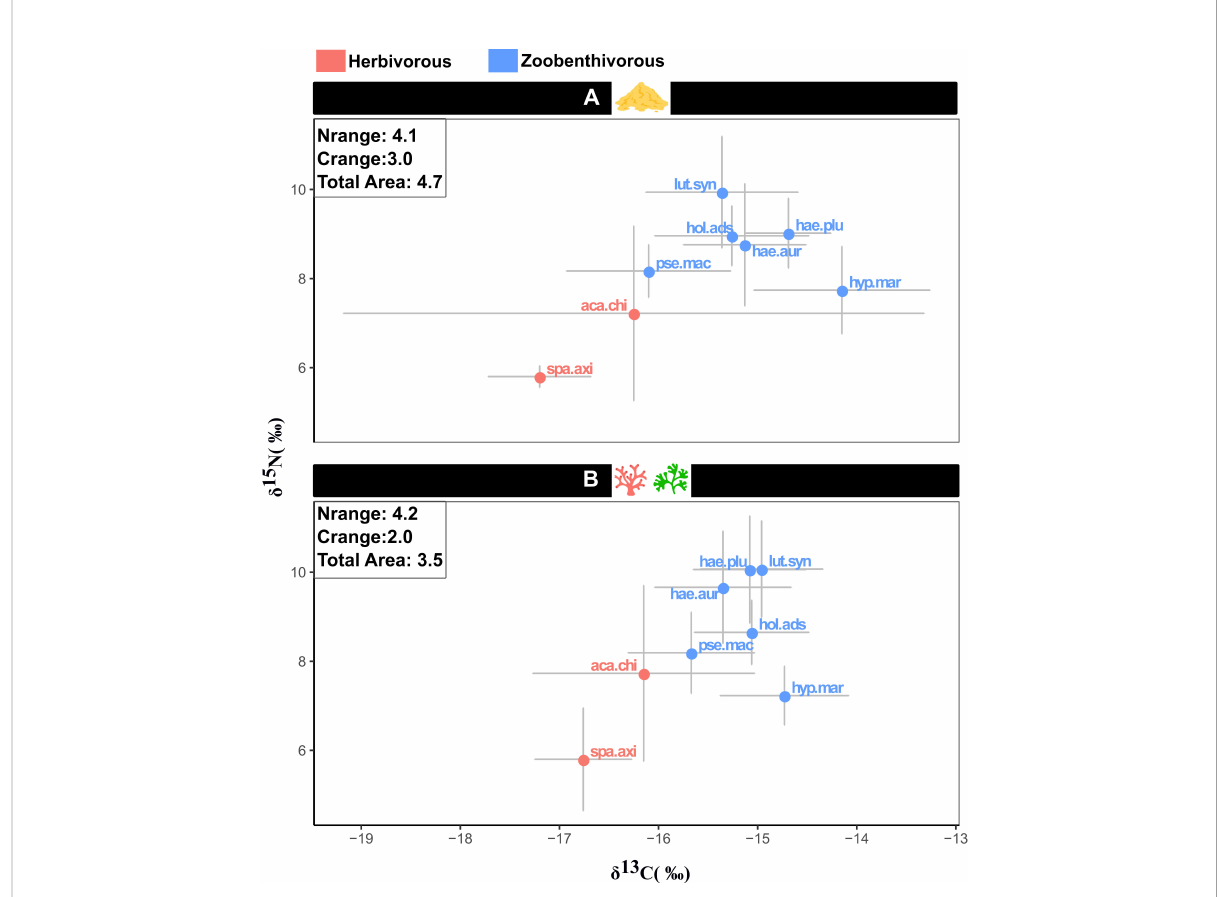
FIGURE 4 Biplot showing the mean and standard deviation of carbon and nitrogen isotopic compositions of the eight selected species in zones (A) (sand- dominated) and (B) (complex substrates). The fi sh community ’ s nitrogen/carbon range and total isotopic area in each zone are shown on the biplots. lut.syn, Lutjanus synagris ; pse.mac, Pseudopenneus maculatus ; hae.plu, Haemulon plumierii; hae.aur, Haemulon aurolineatum ; hyp.mar, Hypanus marianae ; hol.ads, Holocentrus adscencionis ; aca.chi, Acanthurus chirurgus ; spa.axi:, Sparisoma axillare